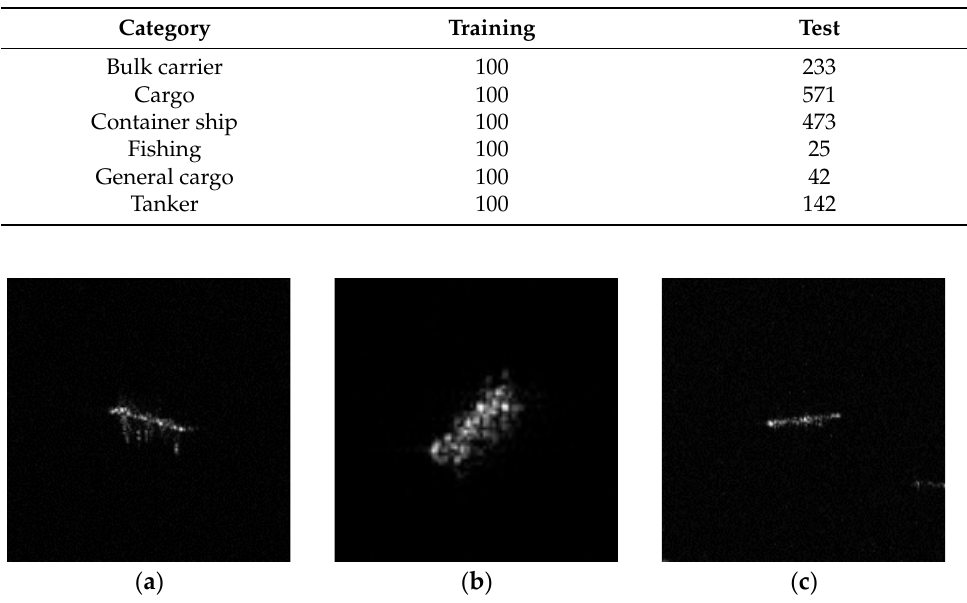
Table 3. Six-Category Data.